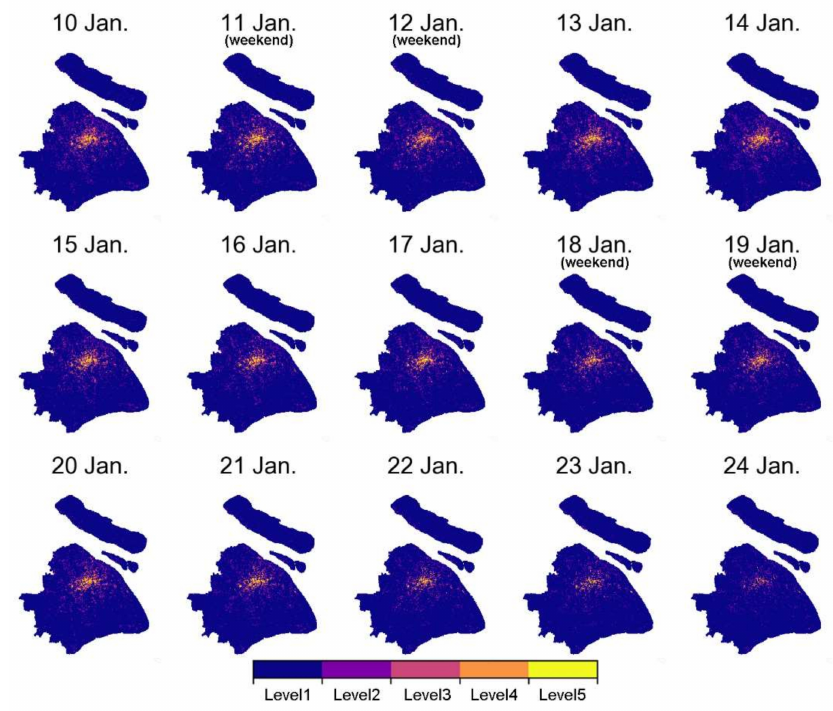
Figure 7. Spatial distribution of internode transmission risk from 10 January 2020, to 24 January 2020.